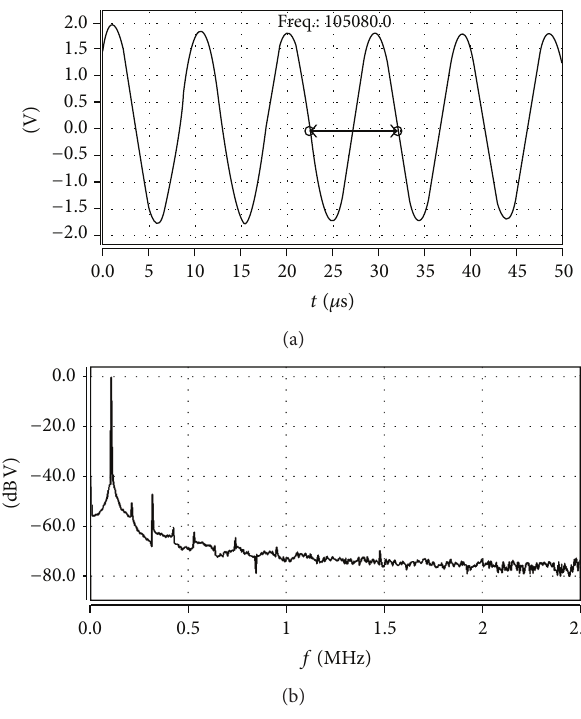
Figure 9: Simulation results for the circuit (Figure 4(a)) using CMOS OTRA (Figure 2): (a) output waveform and (b) correspond- ing frequency spectrum.